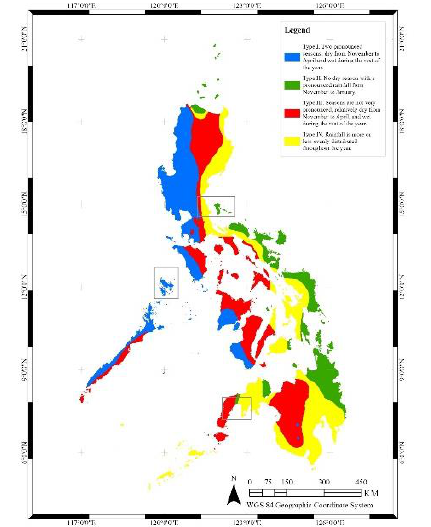
Figure 1. The location of the three (3) study sites and their corresponding climate types based on the Coronas classification for the radar image analysis of mangroves: (1) the province of Quezon, (2) the municipality of Coron in Palawan and (3) the province of Zamboanga Sibugay.